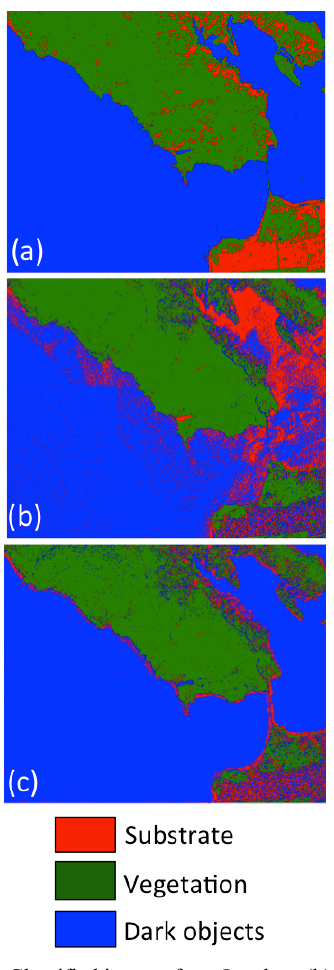
Figure 3: (a) Classified images from Landsat, (b) WV-2 data, and (c) fused data.